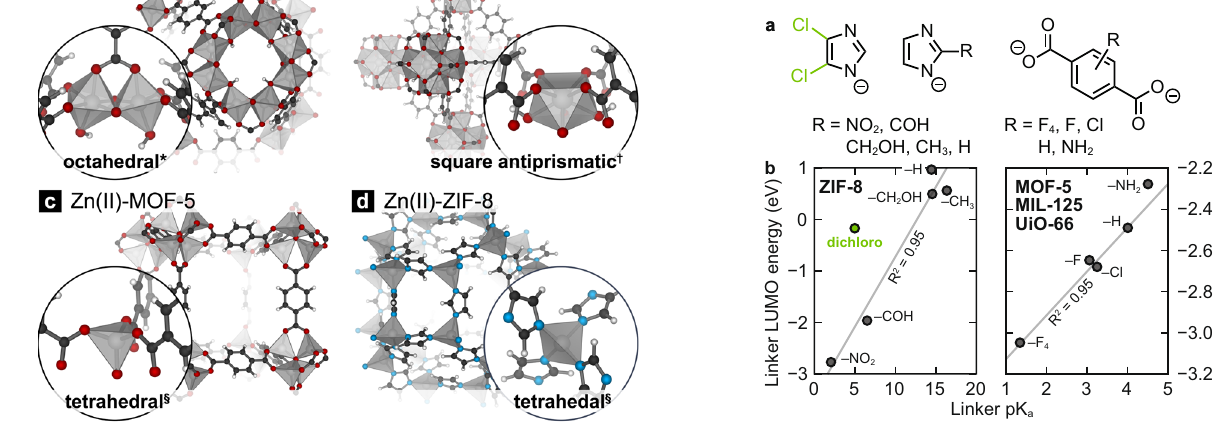
Fig. 2 An examination of the metal coordination environments in four common MOFs. Four MOFs considered in this ligand functionalization study. a Ti-MIL-125 features octameric Ti(IV)-centers in (*pseudo) octahedral environments. b Zr-UiO-66 features 7-coordinate Zr(IV) centers in ( † pseudo)square antiprismatic coordination. c Zn-MOF-5 is constructed from ( § pseudo)tetrahedral Zn(II) centers that form a super tetrahedral Zn 4 O cluster. d Zn-ZIF-8 features ( § pseudo)tetrahedral Zn(II) centers, only lowered in symmetry by the polarization of the linker.